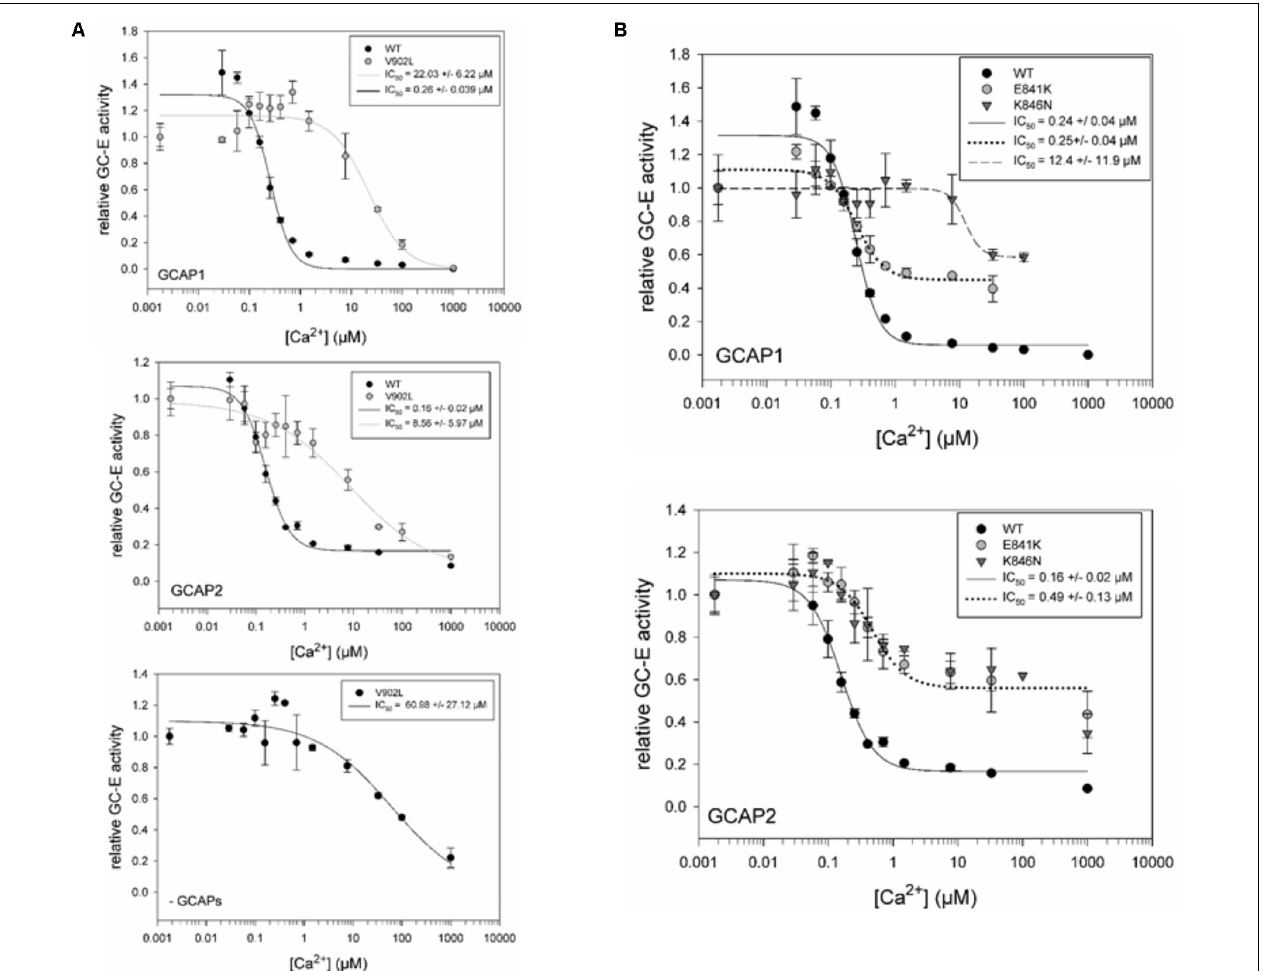
FIGURE 4 | IC 50 measurements for GC-E wildtype and mutants. (A) Comparison of GC-E wildtype and mutant V902L, activated by GCAP1 (upper panel) and GCAP2 (middle panel). An additional Ca 2 + titration of the mutant V902L (lower panel) without GCAPs was performed. (B) Comparison of GC-E wildtype with the mutants E841K and K846N. GC-E from HEK cells and GCAPs (5 µ M) were incubated at different [Ca 2 + ] ranging from 1.7 nM to 1 mM. The relative GC-E activity was calculated via the amount of produced cGMP. The GC-E activity at the lowest [Ca 2 + ] was set to 1. IC 50 values are indicated in the graph and represent the half-maximal inhibition by Ca 2 + . Each data point represents the mean value of three replicates with the standard deviation. The experiment was repeated for GC-E wildtype and V902L with similar results. The data were fitted in SigmaPlot 11.0 with a Hill 3 parameter fit. The inset shows IC 50 values with the standard error of the